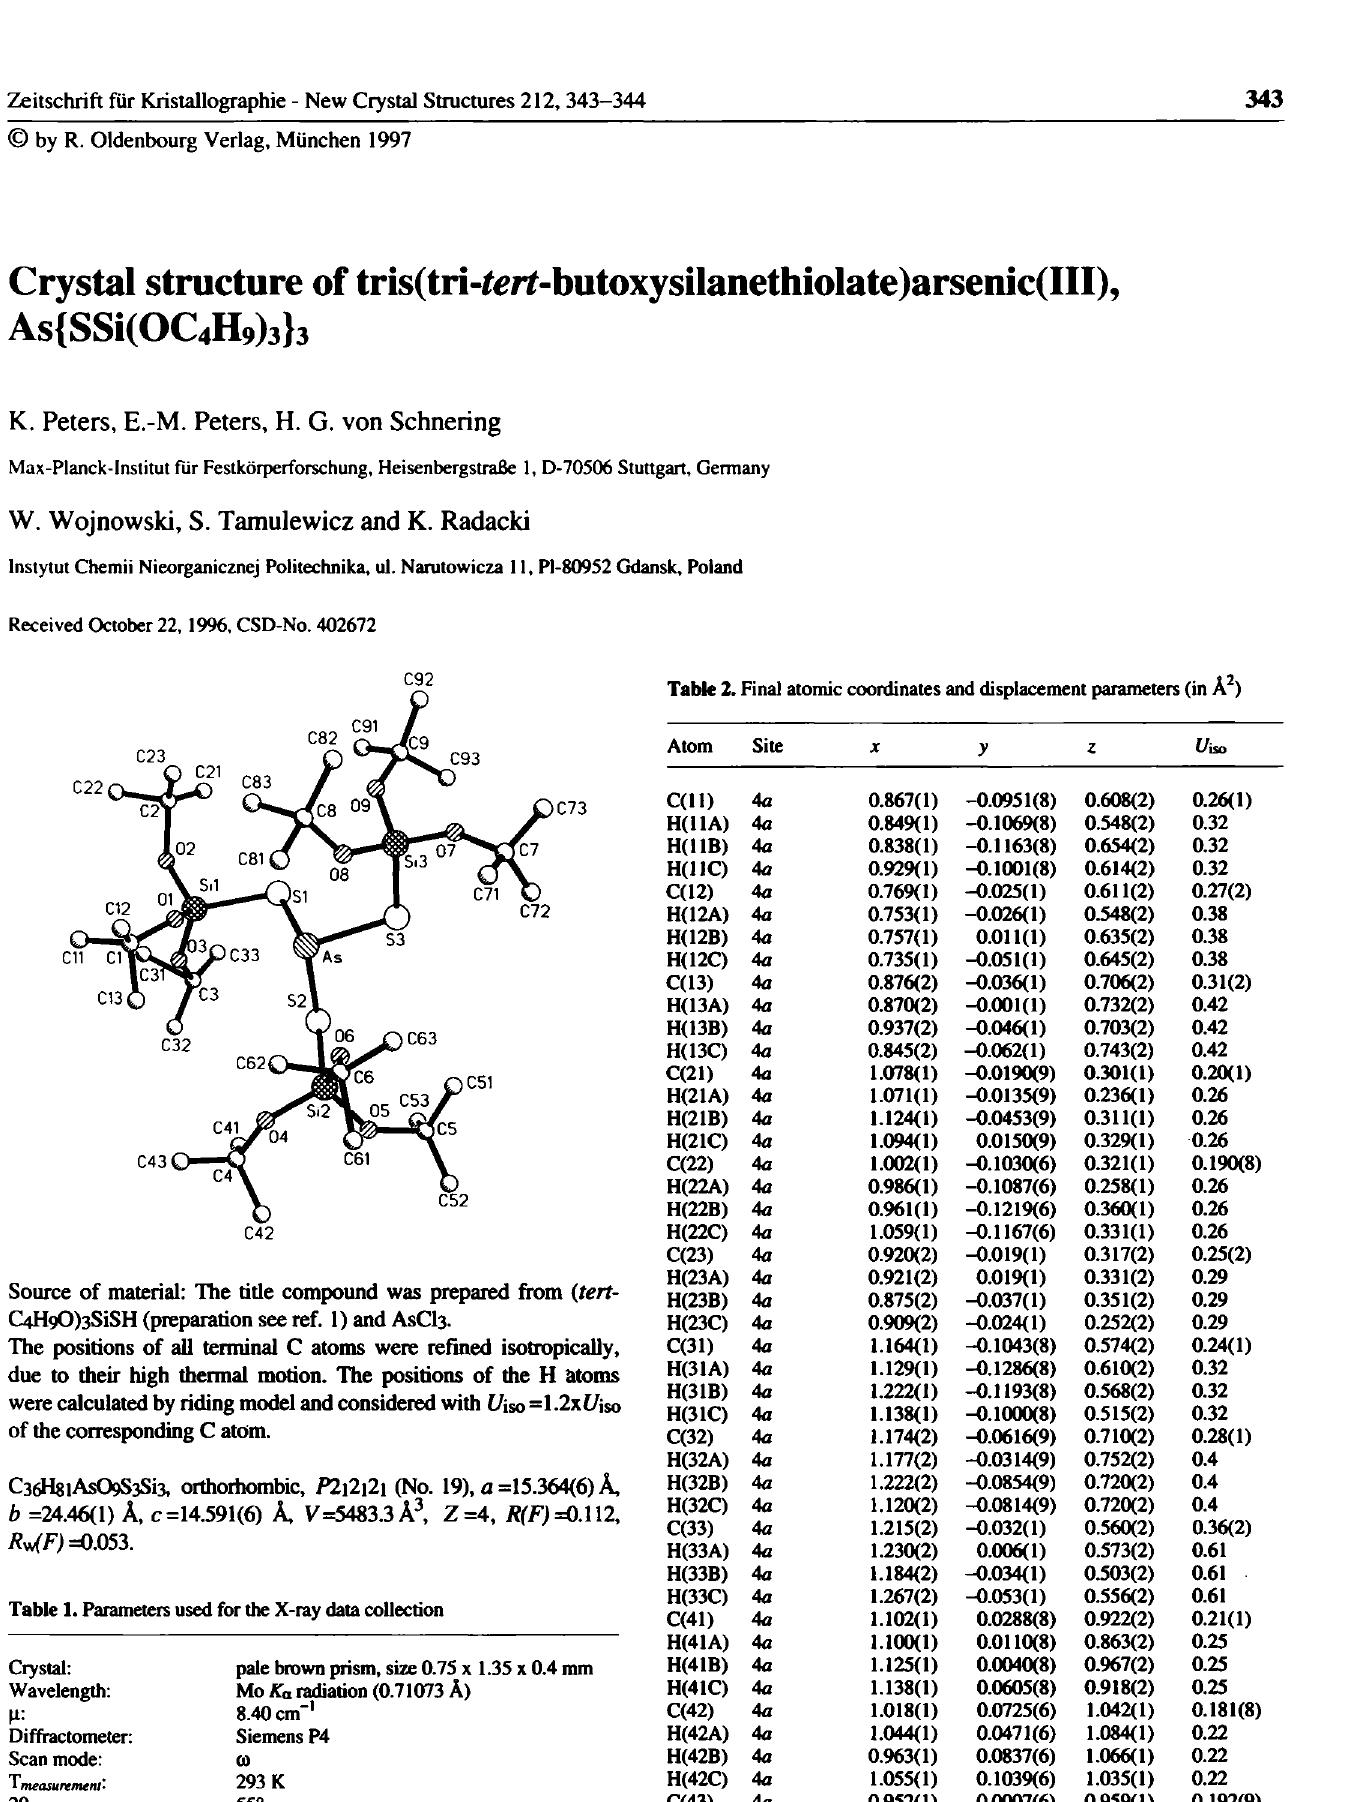
Table 1. Parameters used for the X-ray data collection Crystal: